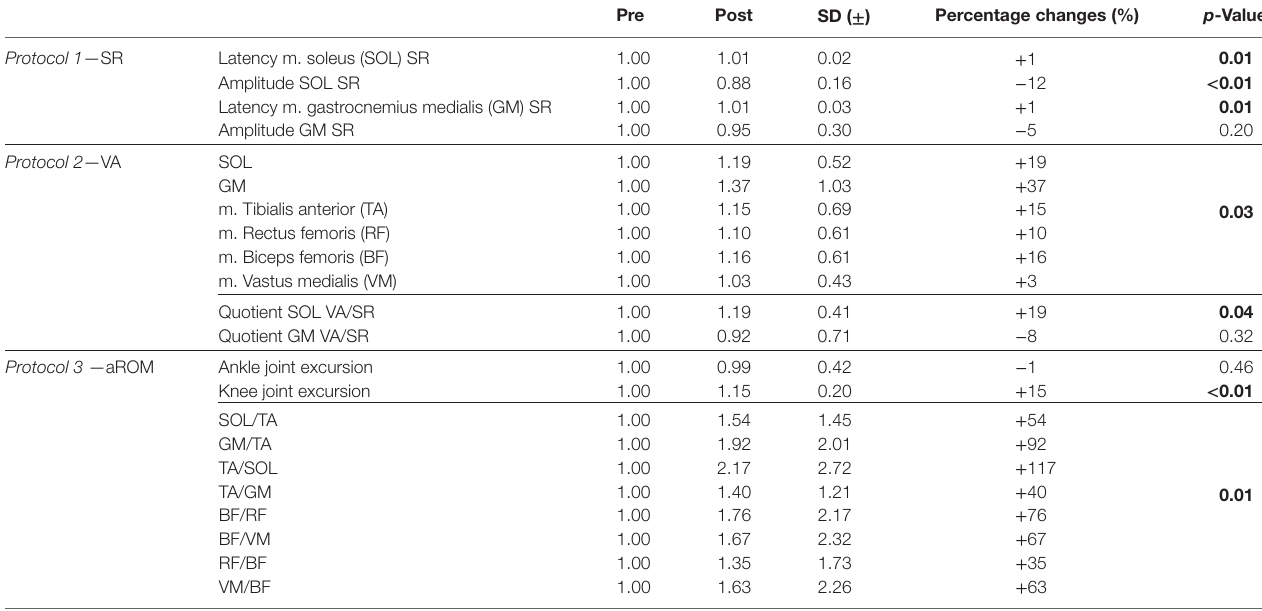
TaBle 1 | Results of stretch reflex (SR, Protocol 1 ), maximal voluntary muscle activation (VA, Protocol 2 ), and active range of motion (aROM, Protocol 3 ) normalized to baseline values ( =